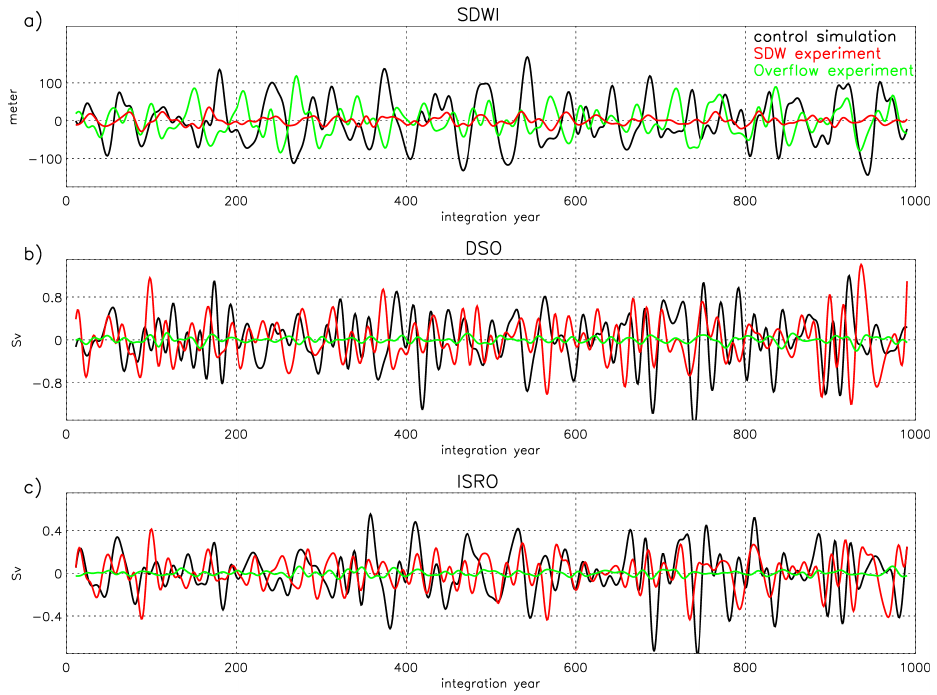
Fig. 7. Anomalous bandpass-filtered (15–80 years) (a) SDWI (in m), (b) DSO (in Sv) and (c) ISRO (in Sv) in the control simulation (black lines), the SDW experiment (red lines) and the overflow experiment (green lines) with MPI-ESM-CR. The respective standard deviations are given in the table. Numbers in brackets in the table give the reduction (in %) in the standard deviation in the respective sensitivity experiment compared to the control